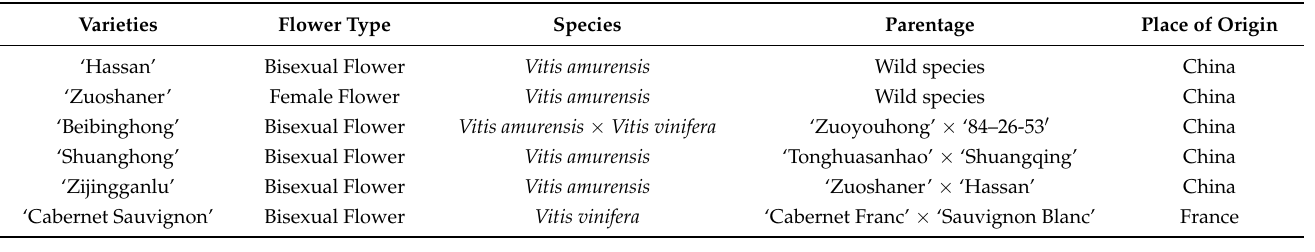
Table 1. Materials used in this study.